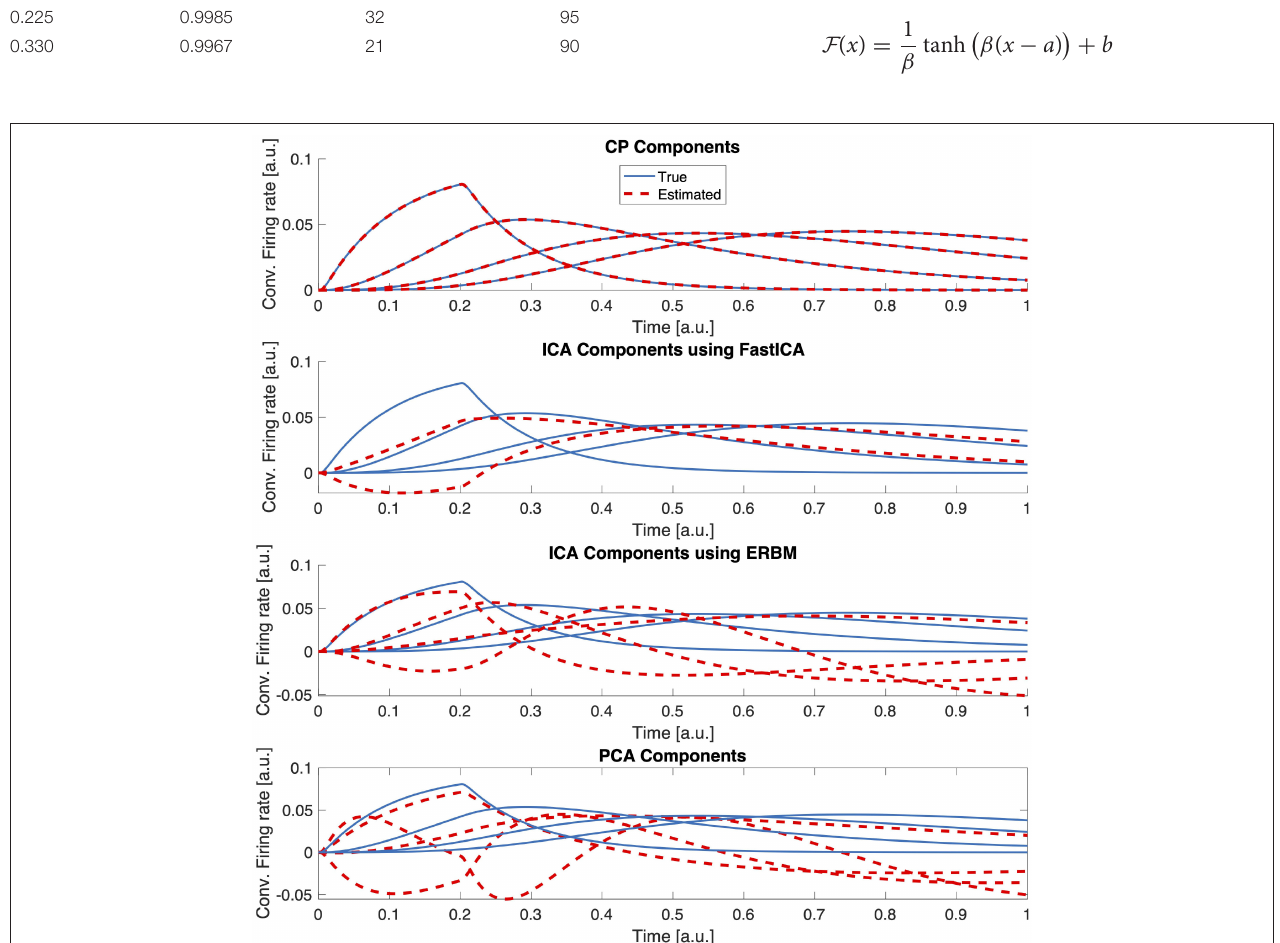
FIGURE 5 | Comparing CP, FastICA, ERBM, and PCA estimates of temporal components. Data was generated without additional noise and the correct number of components was provided to the algorithms.